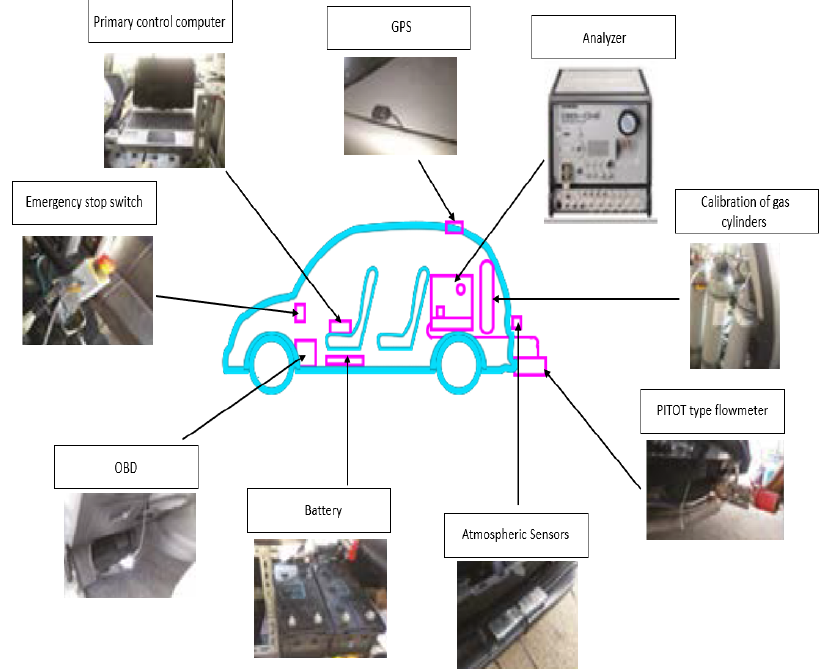
Figure 2. Detailed settings of PEMS installation [10].